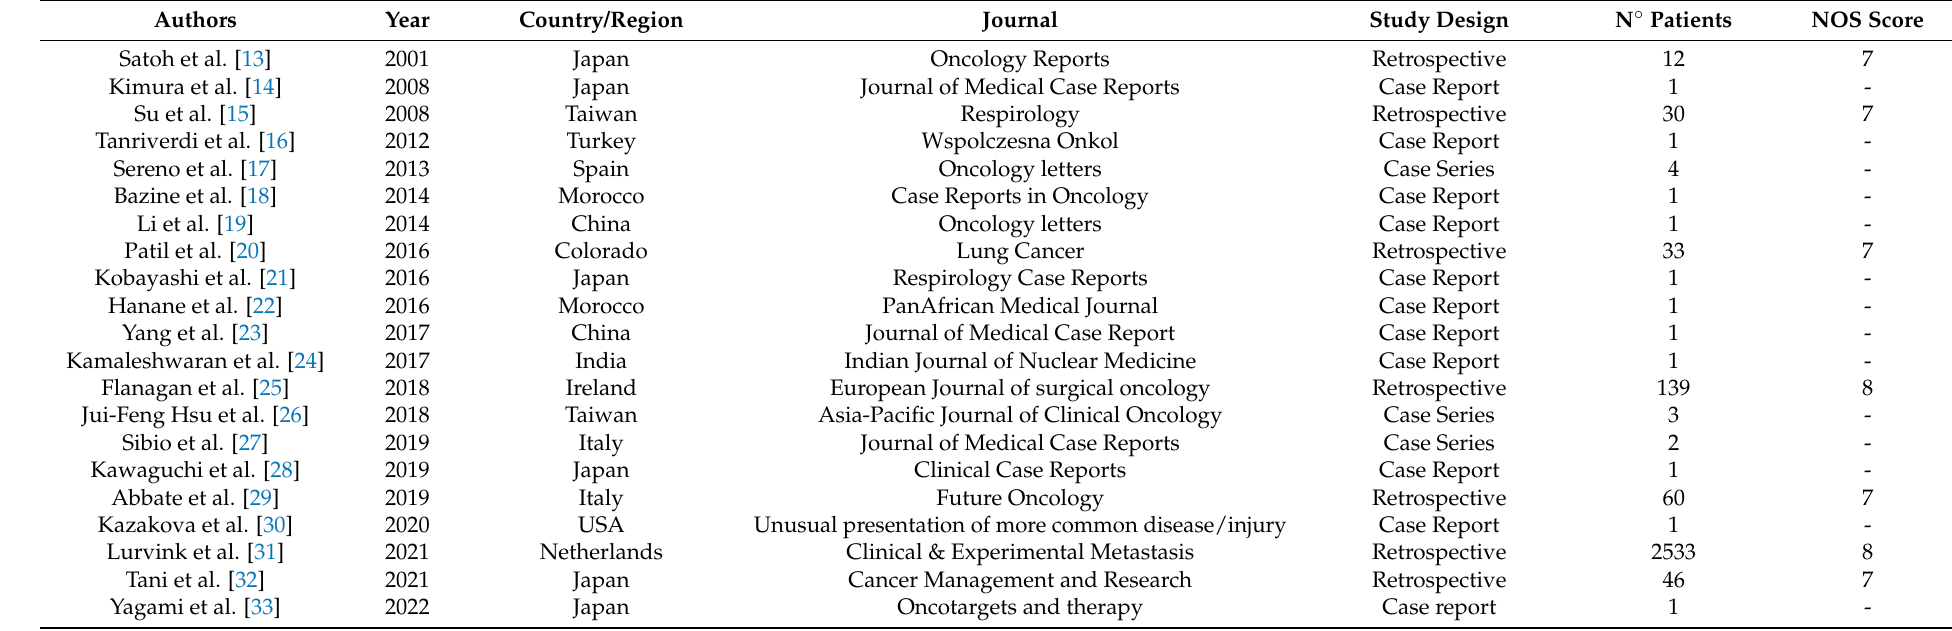
Table 1. Characteristics of studies included in the review.